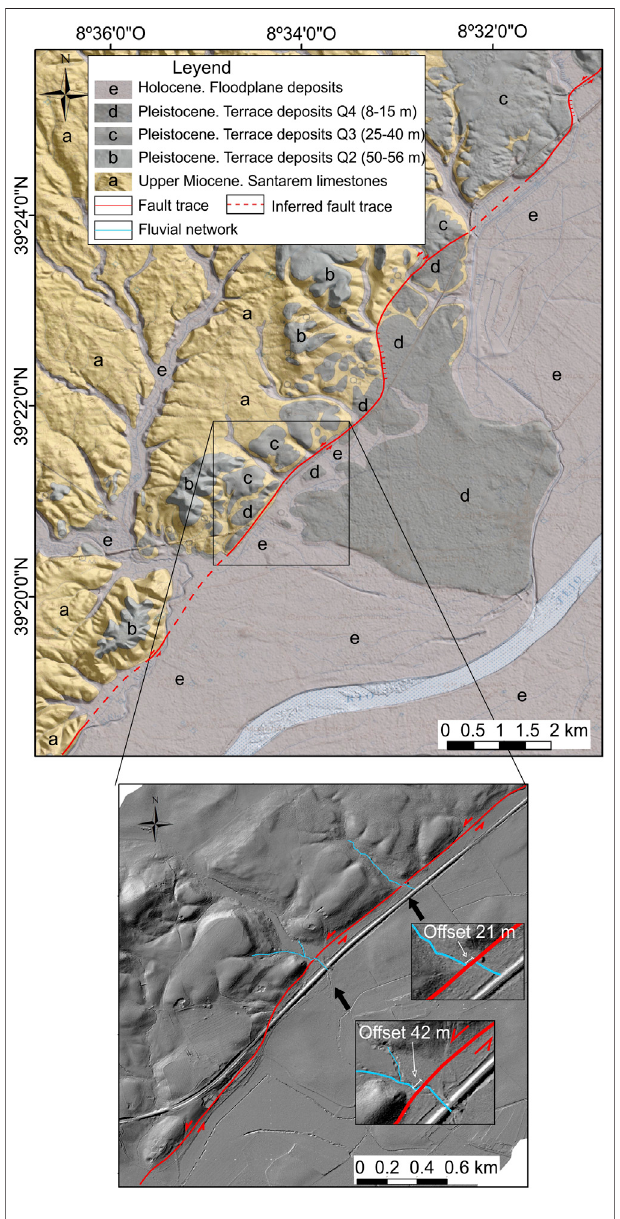
FIGURE 2 | The LTVFZ traces in the study area represented with a red line (dashed where inferred): (A) superimposed on the 1:50.000 scale geological map and 0.5 m resolution DEM; (B) detail showing two channels affected by offsets.